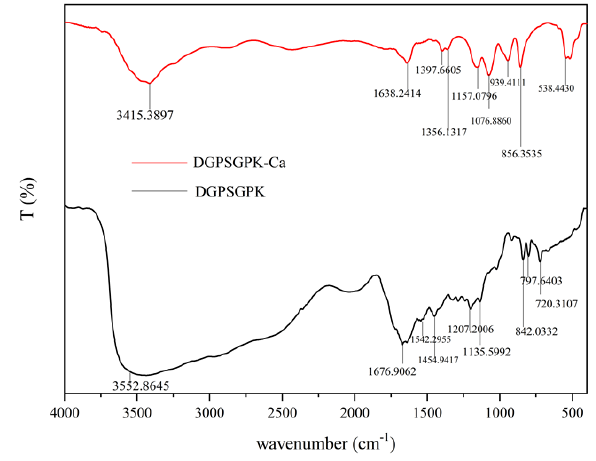
Figure 4. Infrared scanning spectrum of DGPSGPK and DGPSGPK − Ca.